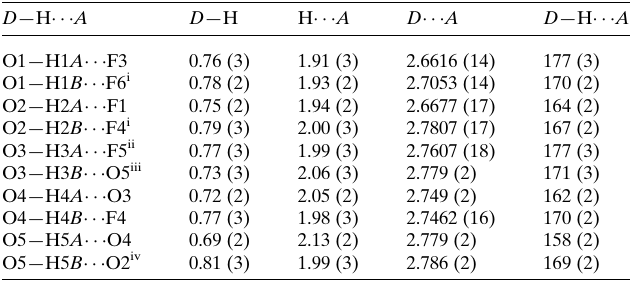
Table 2 Hydrogen-bond geometry (A˚ , (cid:4) ) for (IV).